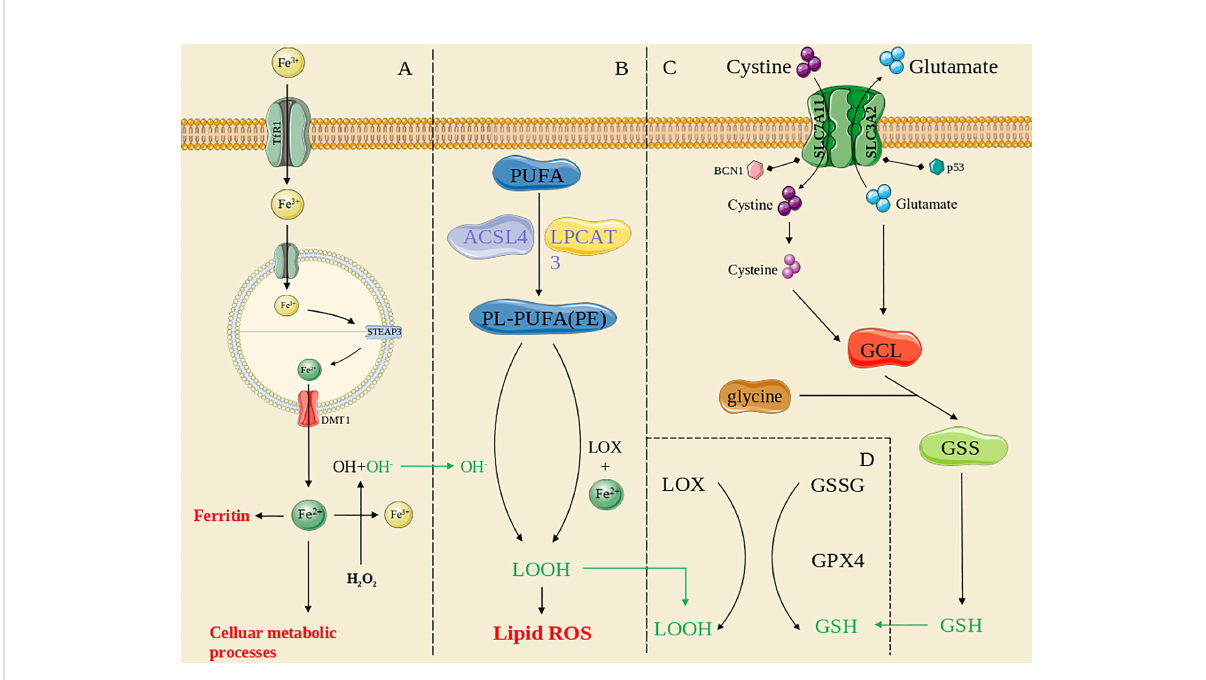
FIGURE 1 The overview of ferroptosis pathways. (A) : the iron metabolism pathway; (B) : the lipid peroxidation pathway; (C) : the antioxidant systems pathway; (D) : the GPX4-mediated pathway. The green line means the substance acts across